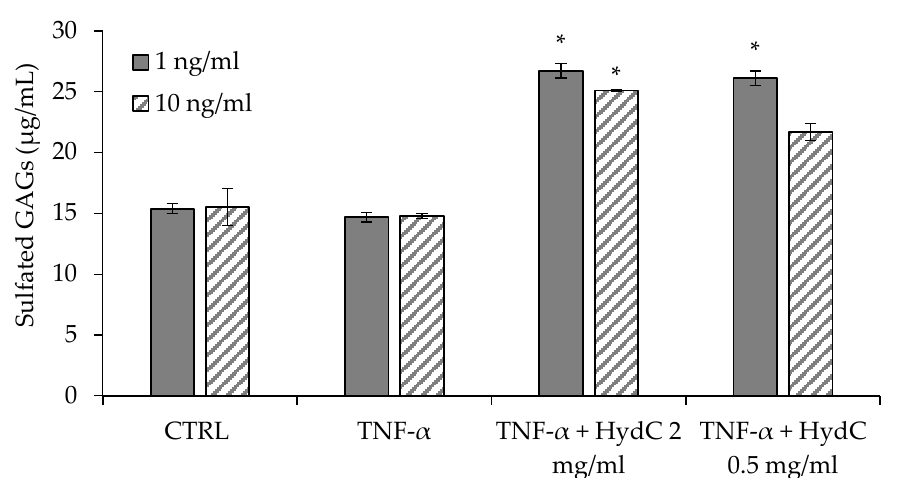
Figure 7. Levels (ng/mL) of sulfated glycosaminoglycans (sGAGs) secreted by HTB-4 cells after a 24-h stimulation with TNF- α at 1 ng/mL and 10 ng/mL, and the treatment with HydC (0.5 and 2 mg/mL) (* p < 0.05). CTRL: HTB-4 in basal medium.